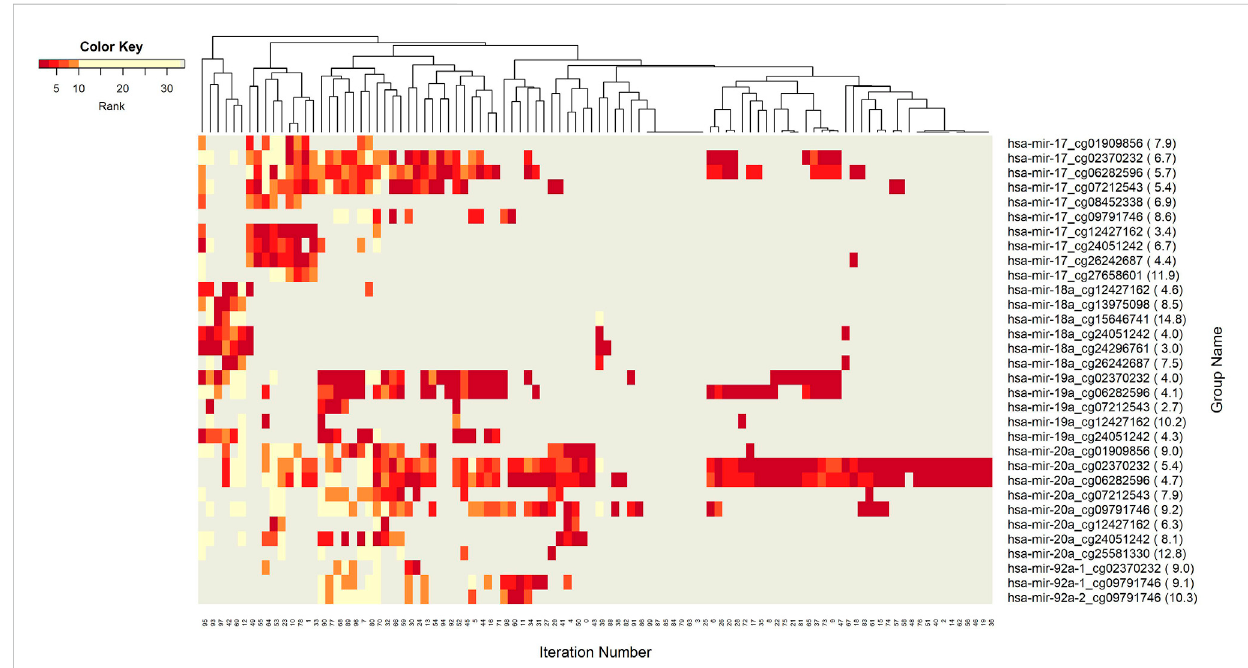
FIGURE 3 Heatmap of Group features with rank information for each split. The heatmap reveals patterns of co-occurrence of groups over different splits. Color key encodes the rank of each group, where 1 indicates the top rank. Gray indicates non-detection of that group for the corresponding split.